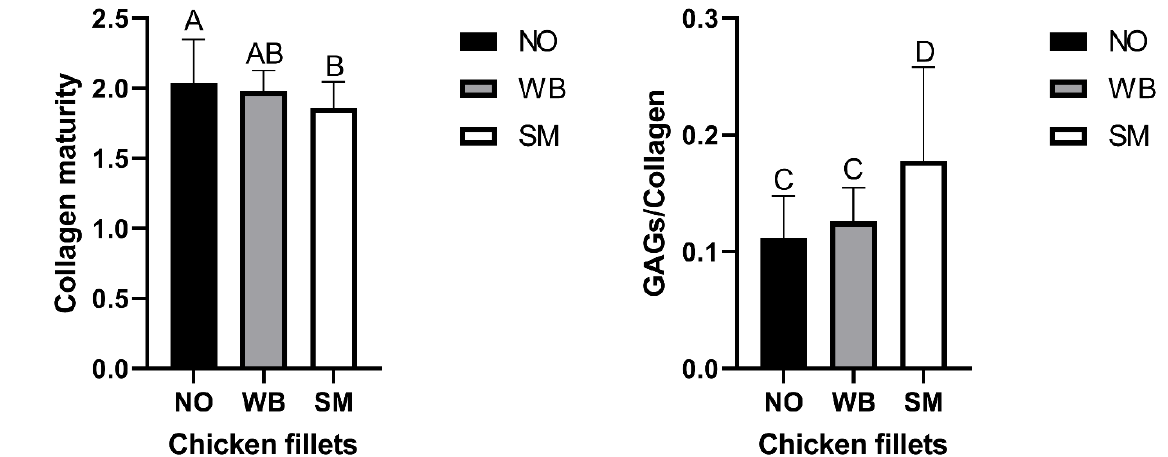
Figure 5. ( Left ): Collagen maturity (1660 cm − 1 /1690 cm − 1 ): The NO and WB fillets show the most mature collagen network, the SM fillets express the lowest degree of maturation, and it is significantly different from NO ( p < 0.05). ( Right ): GAGs to collagen ratio (1126 cm − 1 /1660 cm − 1 ): SM has a significantly higher content of GAGs than NO and WB. Different letters mean a significant difference for p < 0.05.